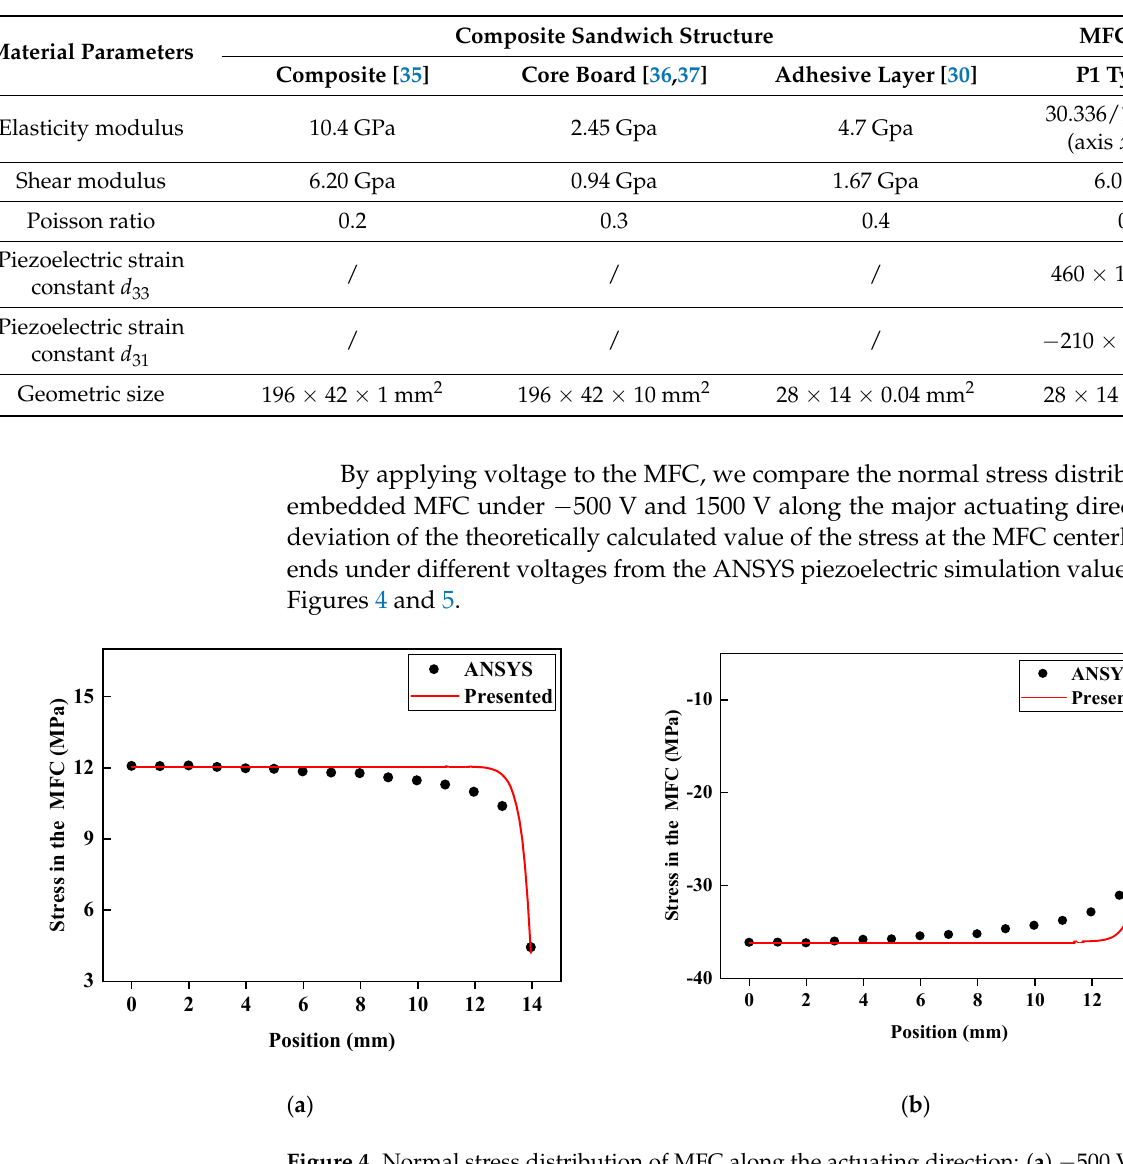
( b ) Figure 5. Relationship between voltage and stress in the MFC: ( a ) Stress in the middle of the MFC; ( b ) stress at the end of the MFC. It can be seen from Figures 4 and 5 that the distribution trend of normal stress in MFC is consistent with the finite element results of ANSYS. Both are smooth and steady in the middle part and have sudden stress changes at the ends. Especially in Figure 4, between the middle and end of MFC, there is a phenomenon whereby the stress calculated by